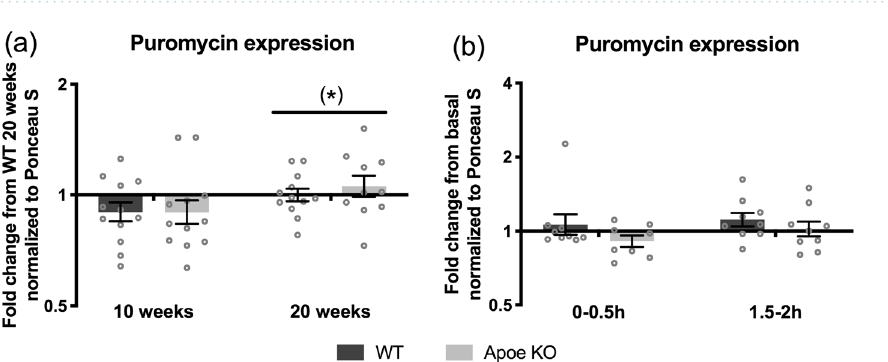
Figure 2. Puromycin incorporation in WT (dark bars) and Apoe KO (grey bars) mice at 10 (WT n = 12, Apoe KO n = 12) and 20 weeks (WT n = 12, Apoe KO n = 10) of age ( A ) and at 0–0.5 h (WT n = 9, Apoe KO n = 9) and 1.5-2 h (WT n = 9, Apoe KO n = 9) after whey protein feeding ( B ). Data were normalized to Ponceau S and in ( A ) expressed as fold change from WT fasted at 20 weeks of age and in ( B ) expressed as fold change from basal. Individual values are shown with bars indicating geometric means ± back-transformed SEM. (*) trend for a difference between time points 0.05 ≤ p < 0.10. Full lane representative blots are shown in Supplementary Figure